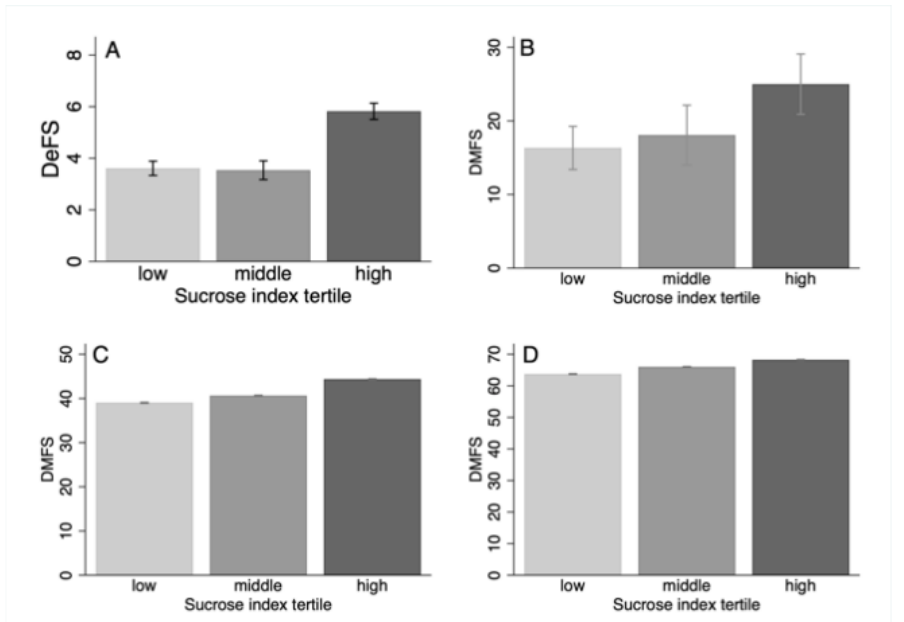
Figure 8. Bar graphs showing sex, age and BMI adjusted mean with 95% CI for caries in ( A ) the 16–21-year-olds ( n = 217) in the derivation group, and ( B ) 30–33-year-olds in the replication cohort ( n = 119), ( C ) 38–44-year-olds in the replication cohort ( n = 10,523), and ( D ) 55–64-year-olds in the replication cohort ( n = 10,518) by tertile classification from the sucrose index distribution in the replication cohort.